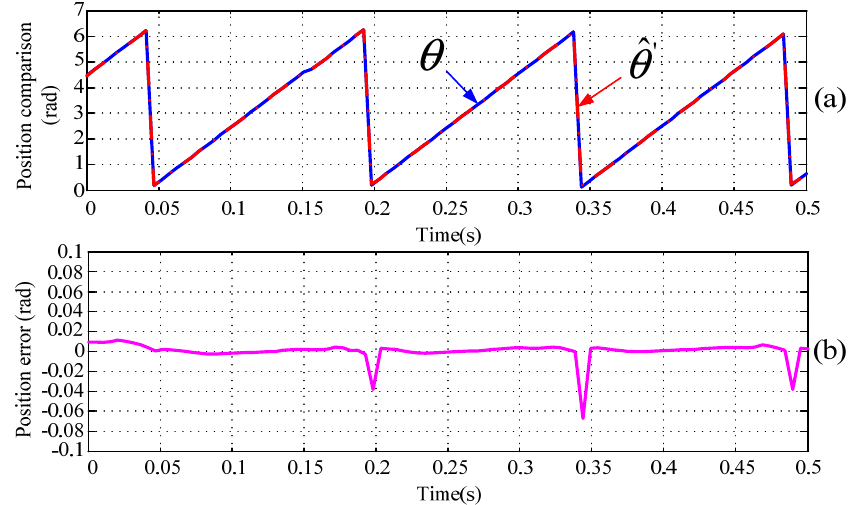
Figure 10. The rotor angle at the motor speed of 100 rpm ( a ) encoder output ( θ ) and rotor angle estimation ( θ′ ˆ ) by NN-ISMO, and ( b ) the estimation error.